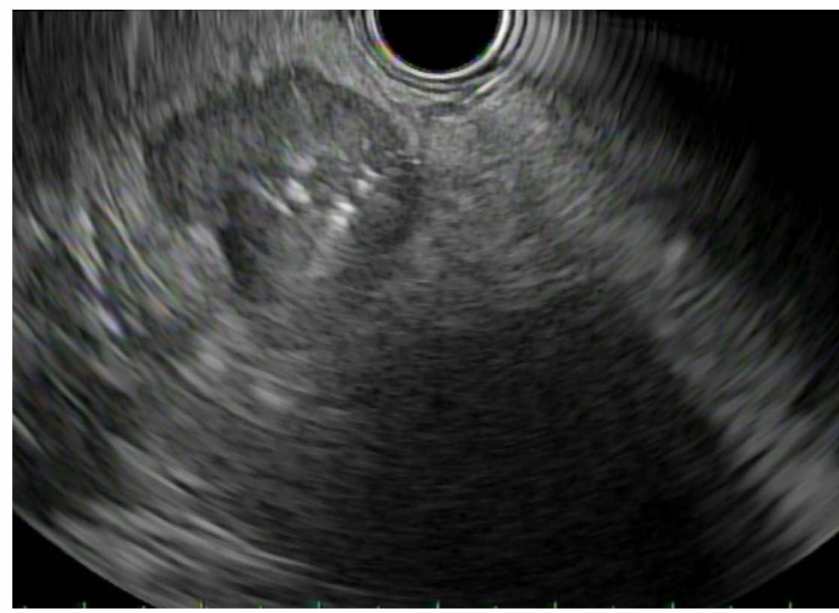
Figure 5. EUS-Radiofrequency Ablation (EUS-RFA): Endosonographic image of a pancreatic lesion being ablated by